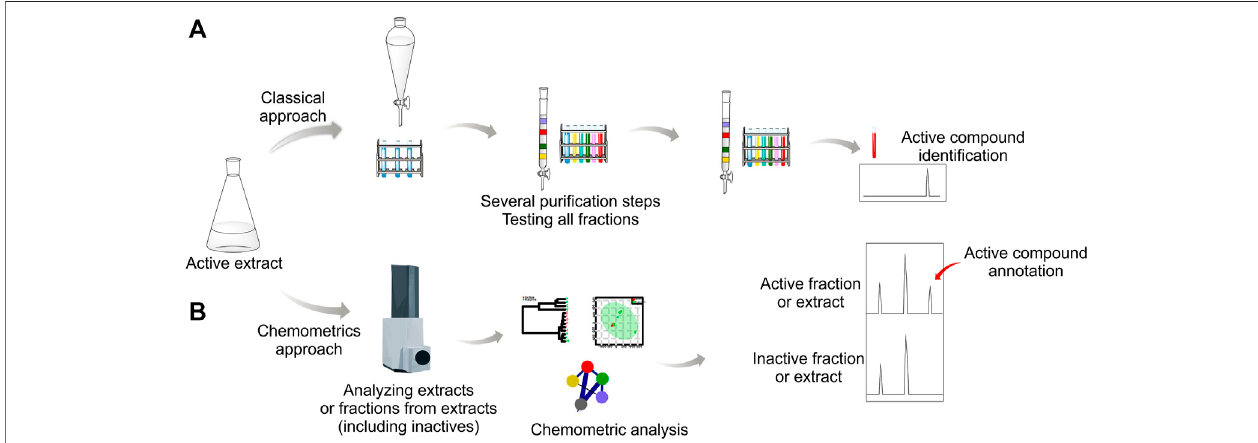
FIGURE 2 | Comparison between classical (A) and chemometric (B) analysis approaches in the isolation of natural products. The classical approach relies on several puri fi cation steps until identifying the chemical(s) responsible for the activity. Chemometrics-based analysis involves the comparison of active and inactive samples to identify the presence of key compounds in active extracts that could be linked to the activity.